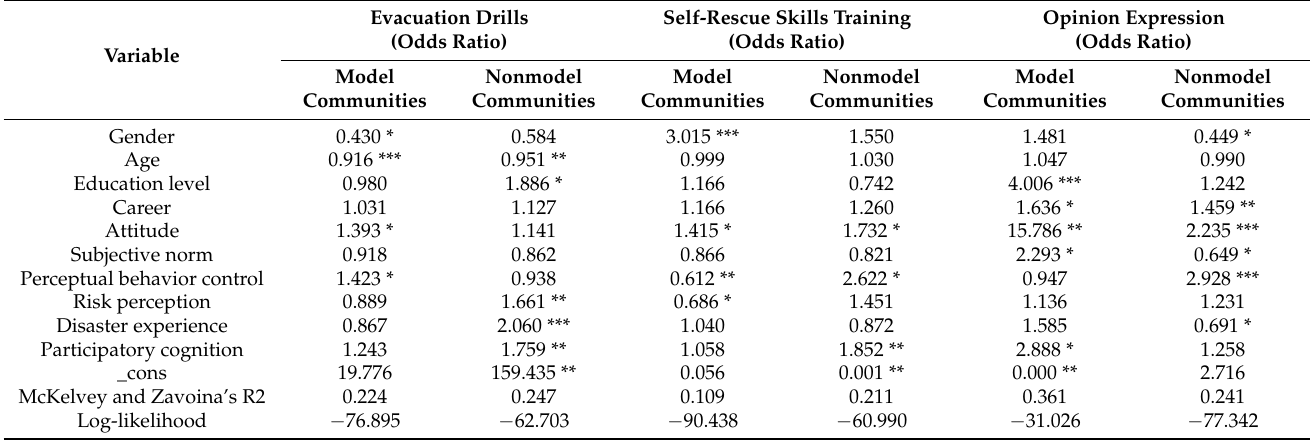
Table 4. Binary logistic model regression results.